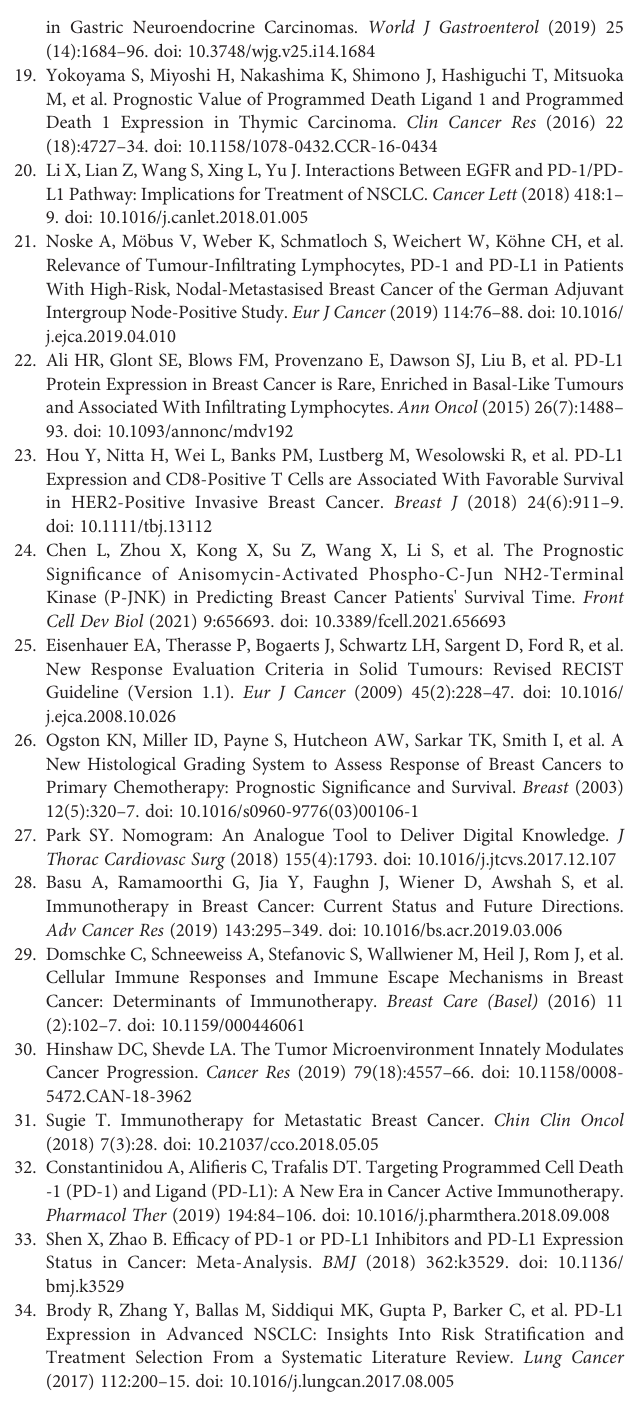
Supplementary Figure 1 | Expression of PD-L1 in human breast cancer